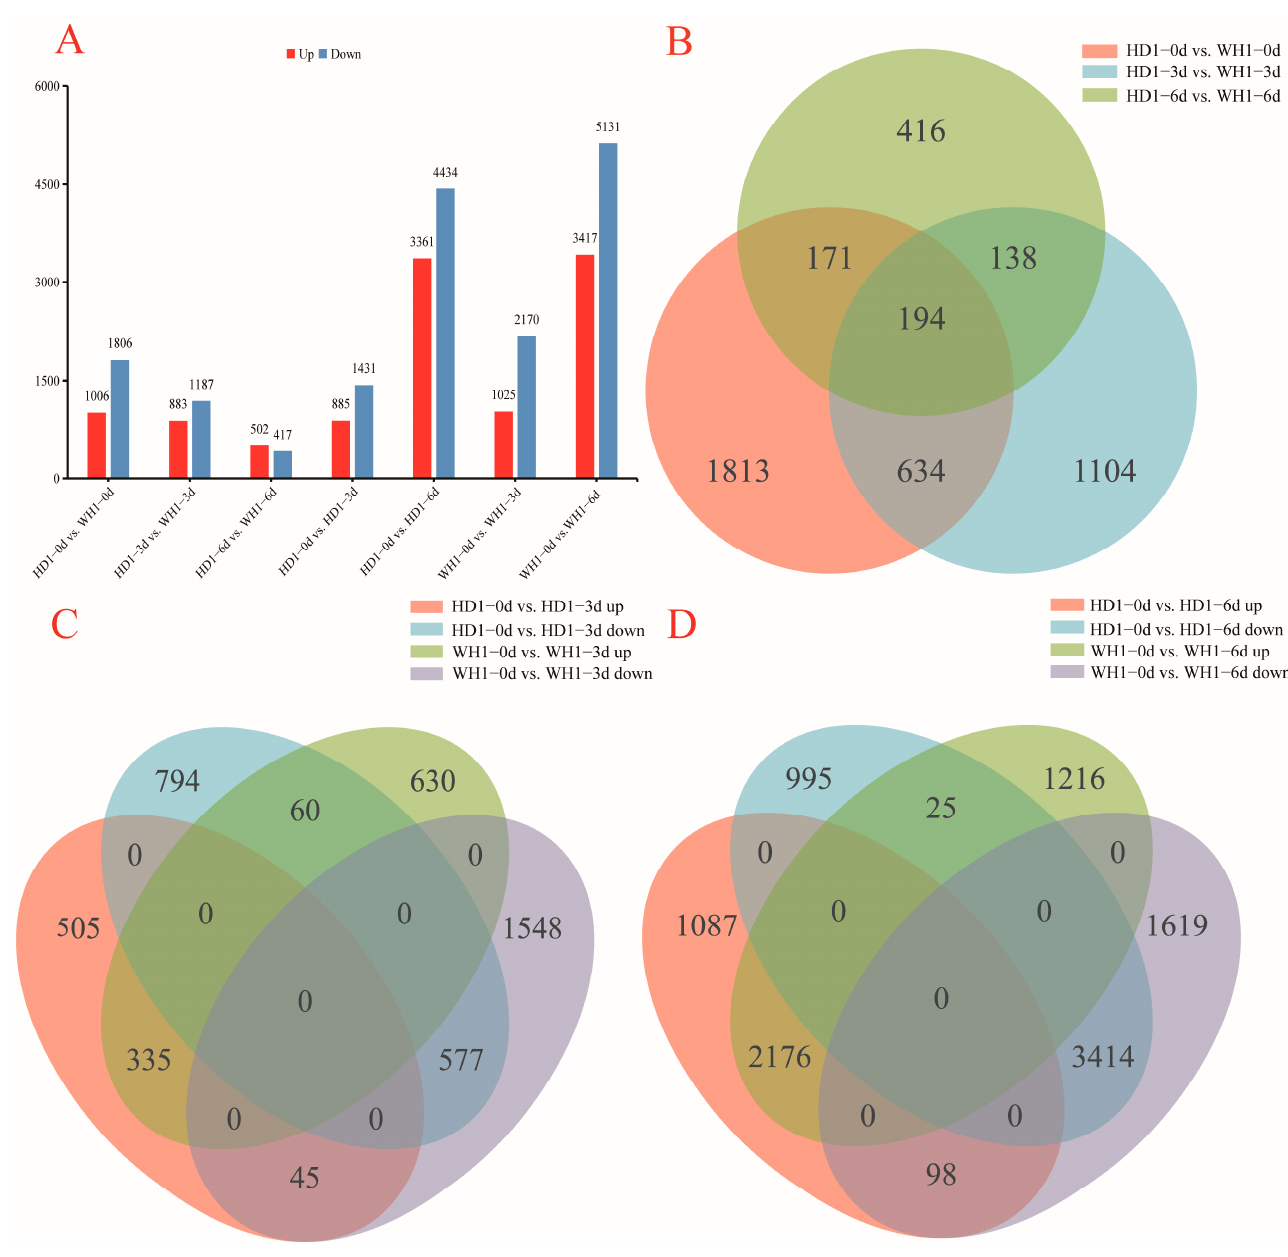
Figure 2. Differentially expressed genes (DEGs) in HD1 and WH1 under PEG stress. The selection of DEGs is based on the cutoff value of p -value < 0.05 and | log2FC | ≥ 2. ( A ): The total number of differentially expressed genes in HD1 and WH1 under PEG stress ( B ): The Venn diagram shows the comparison data between HD1-0d and WH1-0d, HD1-3d and WH1-3d, and HD1-6d and WH1-6d. ( C ): Venn diagram shows the comparison of DEGs expressed by two C. vietnamensis cultivars under PEG stress for 3 d. ( D ): Venn diagram shows the comparison of DEGs expressed by two C. vietnamensis cultivars under PEG stress for 6 d.